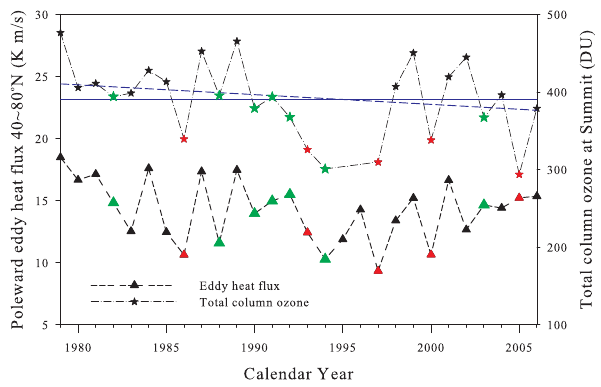
Figure 3. Summit springtime O 3 column density (February and March averages) and poleward eddy heat flux in the lower strato- sphere (40–80 ◦ N, January and February averages) from 1979 to 2006. The solid blue line is the average of springtime O 3 column density from 1979 to 2006 (390 ± 50 (1 σ) DU), and the dashed blue line is the linear least-squared regression of the O 3 column density from 1979 to 2006. The symbols marked as red and green indicate years with double nitrate peaks, while the green symbols indicate one of the double nitrate peaks is accompanied with a sulfate